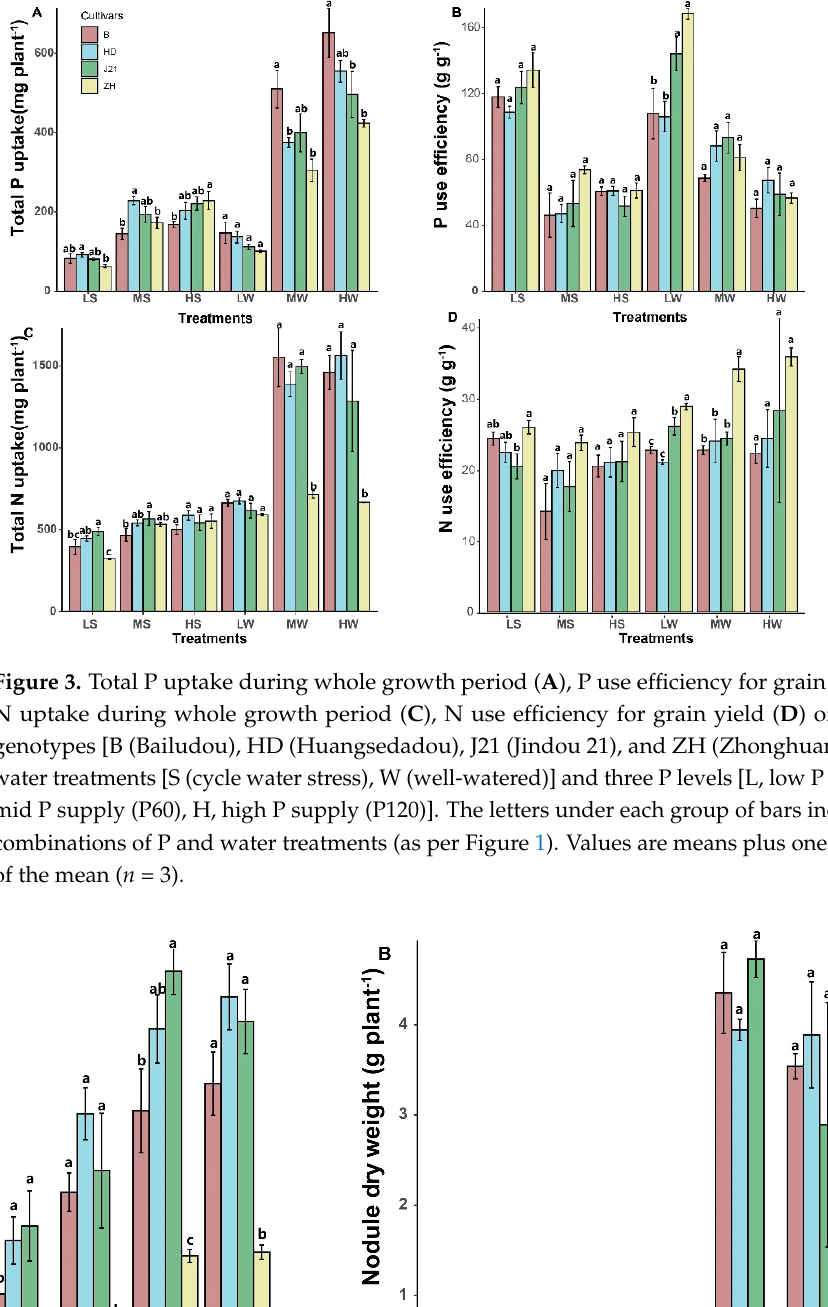
Figure 2. Shoot dry weight ( A ), harvest index ( B ), water use during the whole growth period ( C ), water use efficiency for grain yield ( D ) of four soybean genotypes [B (Bailudou), HD (Huangsedadou), J21 (Jindou 21), and ZH (Zhonghuang)] under two water treatments [S (cycle wa- ter stress), W (well-watered)] and three P levels [L, low P supply (P0), M, mid P supply (P60), H, high P supply (P120)]. The letters under each group of bars indicate different combinations of P and water treatments (as per Figure 1). Values are means plus one standard error of the mean ( n = 3).